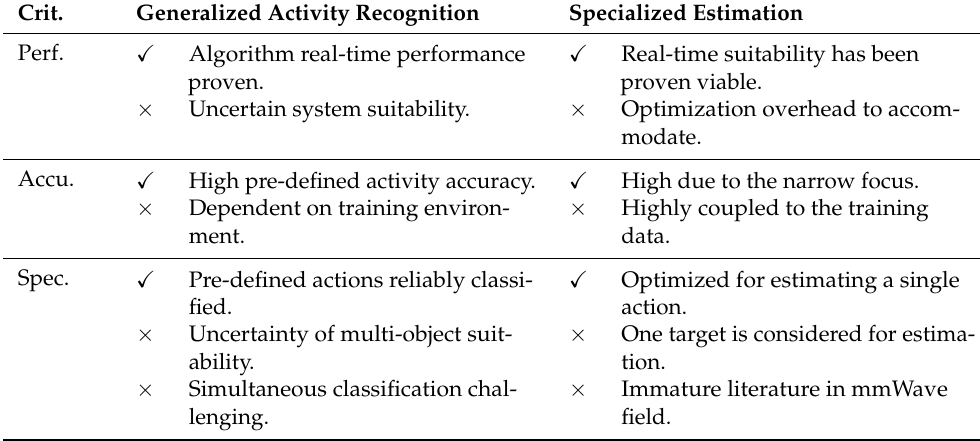
Table 2. Cont. Crit. Generalized Activity Recognition Specialized Estimation Perf. Algorithm real-time